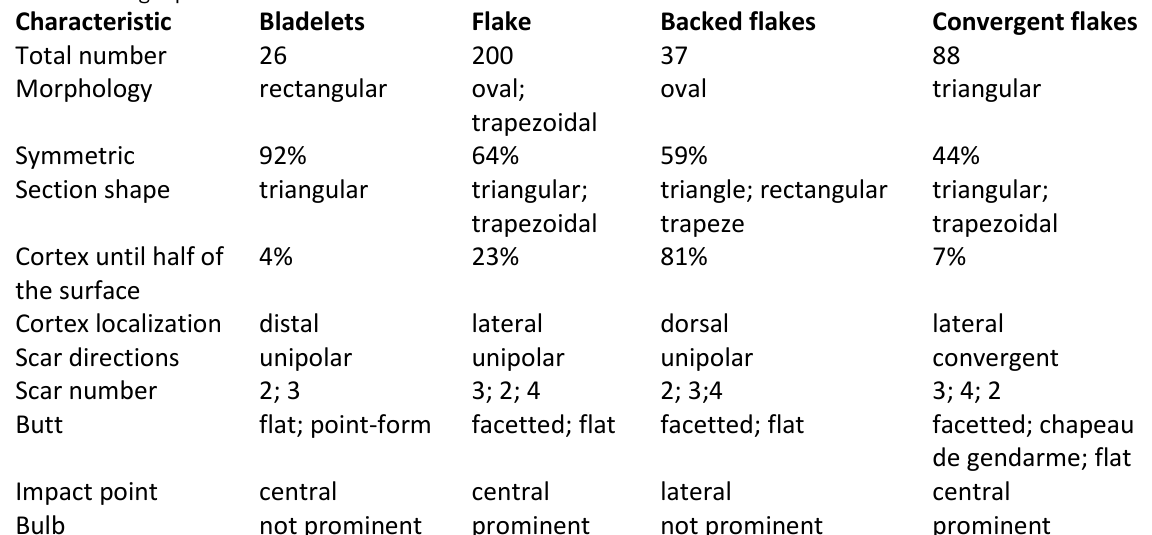
Table 5. Target products main